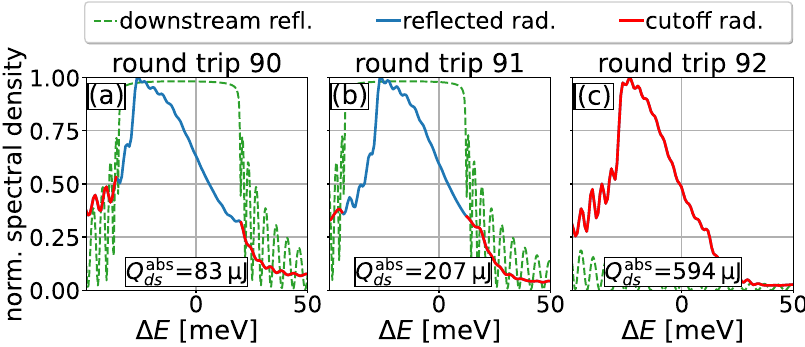
¼ 77 K case after the undulator and before reflection (blue and red solid) together with the spectral FIG. 7. Spectra for the T base reflection curves of the downstream crystal (green dashed), for different round trips around the maximum pulse energy (round trip 92). The blue curve highlights the fraction of the incident radiation which will be nearly completely reflected by the downstream crystal, while the red curve highlights the fraction of the incident radiation which gets cut off, or rather transmitted, at the downstream mirror and is, consequently, more strongly absorbed. This cutoff fraction increases toward round trip 92, which is also highlighted by the increasing amount of absorbed heat energy at the downstream crystal Q abs ds shown at the bottom of each